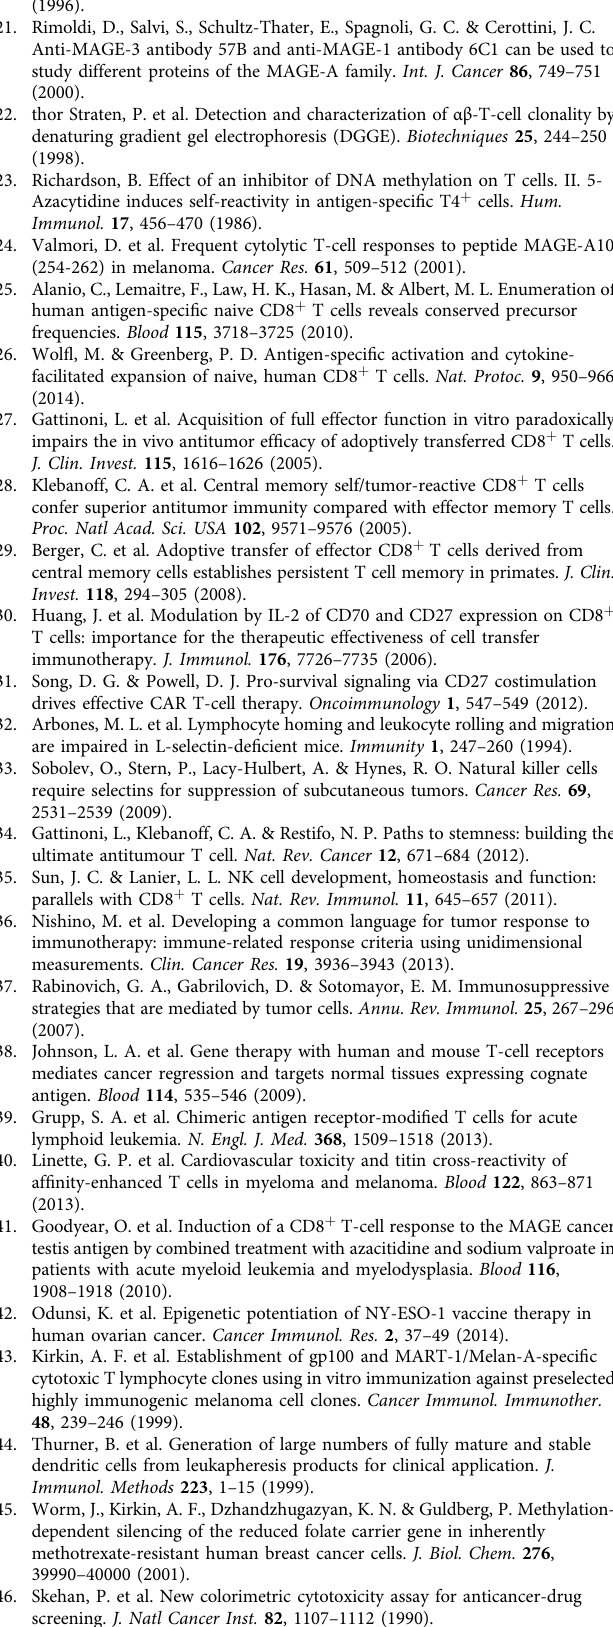
dilutions of cells incubated with supernatants of the MAGE-speci fi c 57B clone 21 were corrected for unspeci fi c binding of isotype-matched IgG1 at the same con- centration. The optical density was measured at 630nm for the non-terminated reactions and at 450nm after termination with HCl.